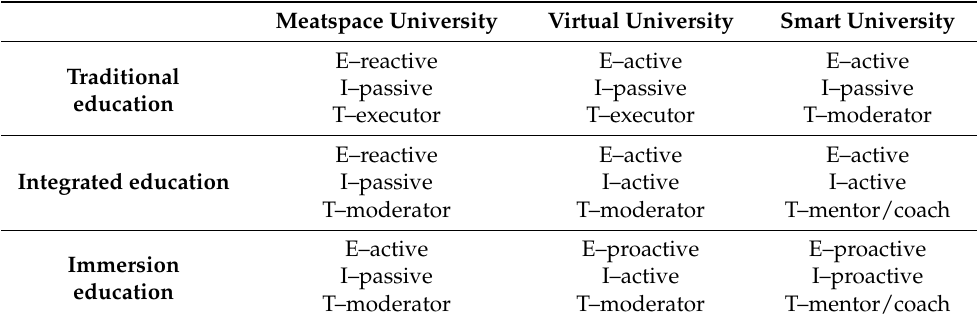
Table 6. A model of future education pathways for intelligent enterprises in line with the Economy 5.0